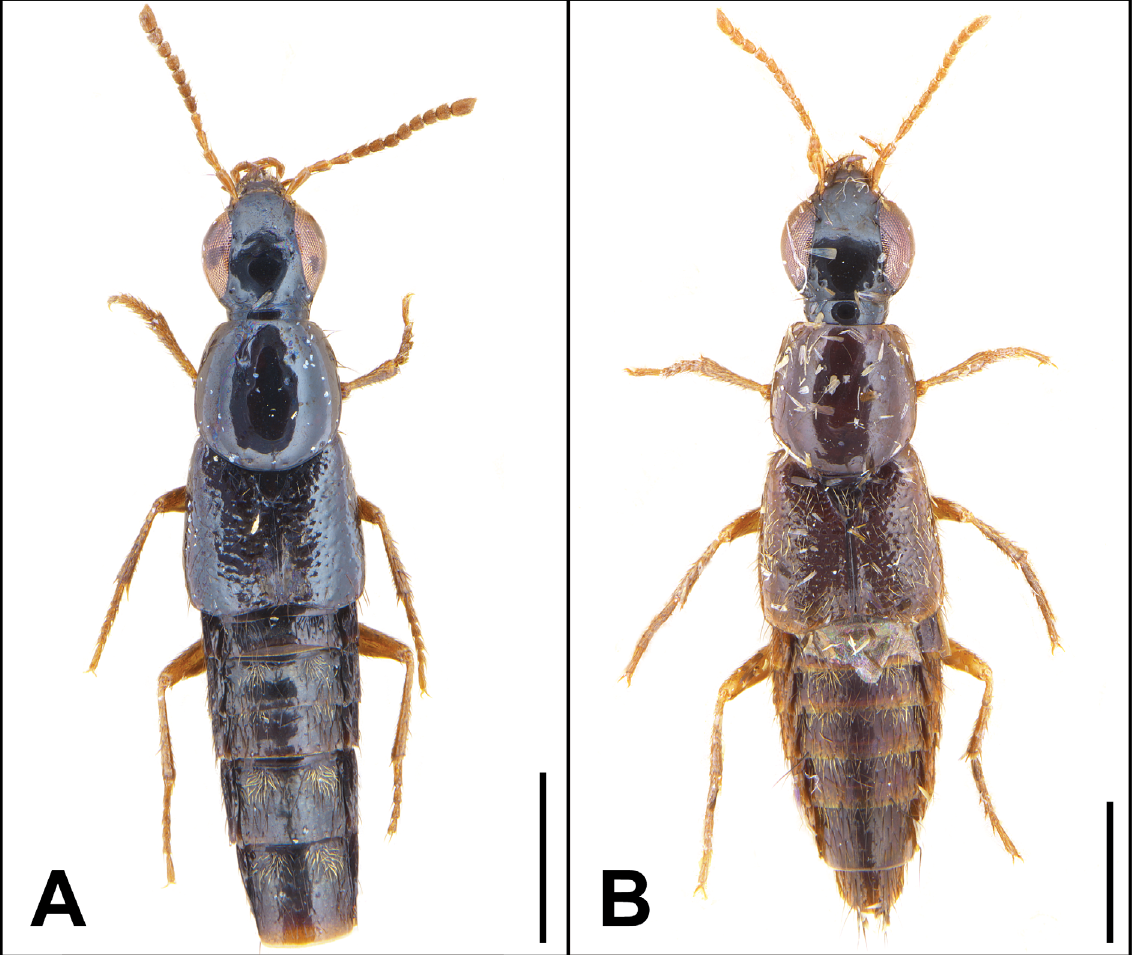
Fig. 3. Dorsal habitus. A. Quedius ( Raphirus ) semilaeviventris Scheerpeltz, 1965, holotype, ♂ (NHRS). B . Q. ( R. ) kambaitiensis Scheerpeltz, 1965 syn. nov. (= Q. ( R. ) muscicola Cameron, 1932), ♀, holotype (NHRS). Scale bars = 1